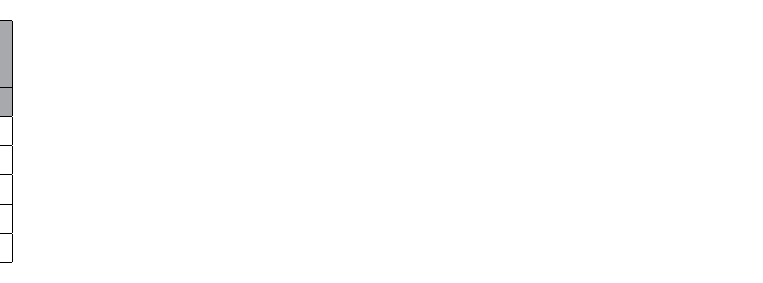
Table 6. Eye lens (*), Petri dish (X) and numerical detector (O) collocation in the different scenarios (see Fig. 2 for details).